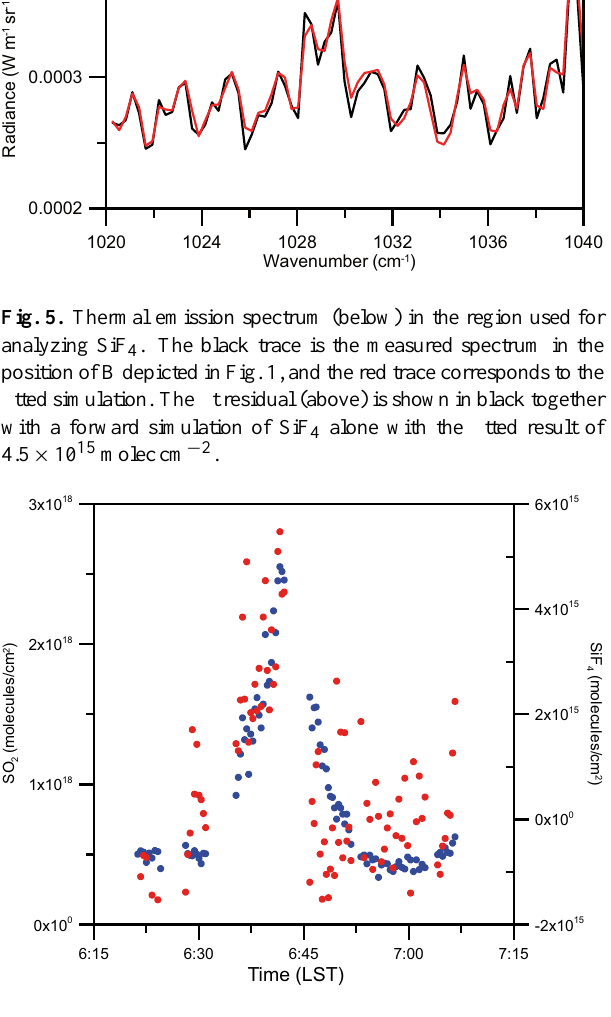
Fig.6. Time-seriesoftheSiF 4 (red)andSO 2 (blue)slantcolumnsretrievedfromlunarabsorptionspectrataken Fig. 6. Time-series of the SiF 4 (red) and SO 2 (blue) slant columns on17November2008. Timeisgiveninlocaltime. retrieved from lunar absorption spectra taken on 17 November 2008. Time is given in local time.